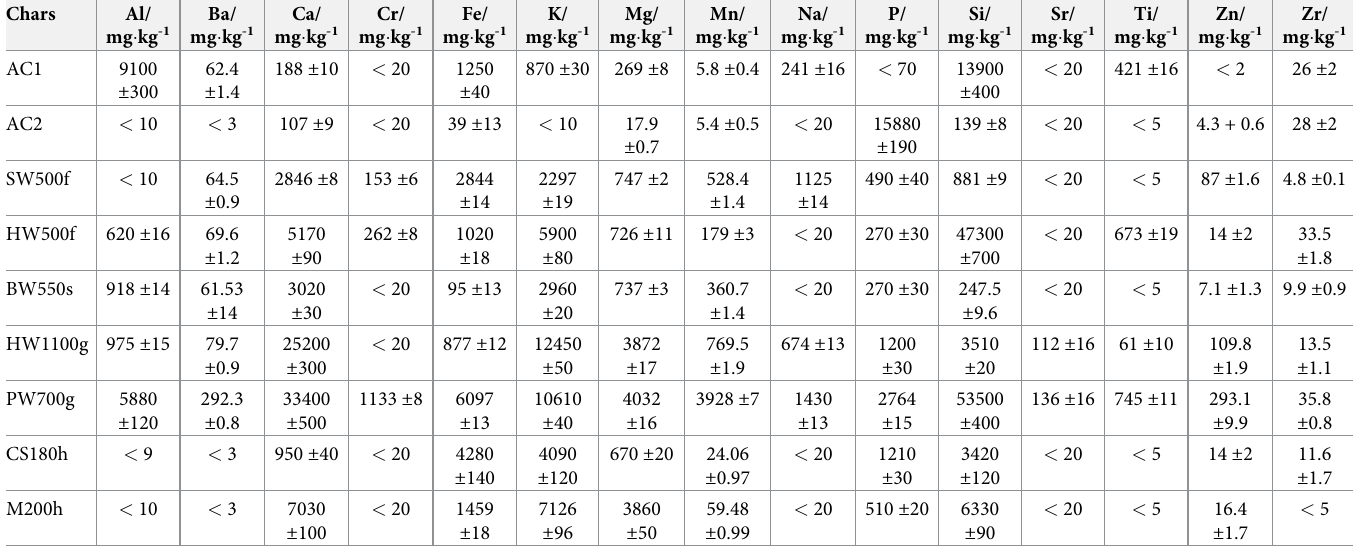
Table 3. Elements determined by ICP-OES.